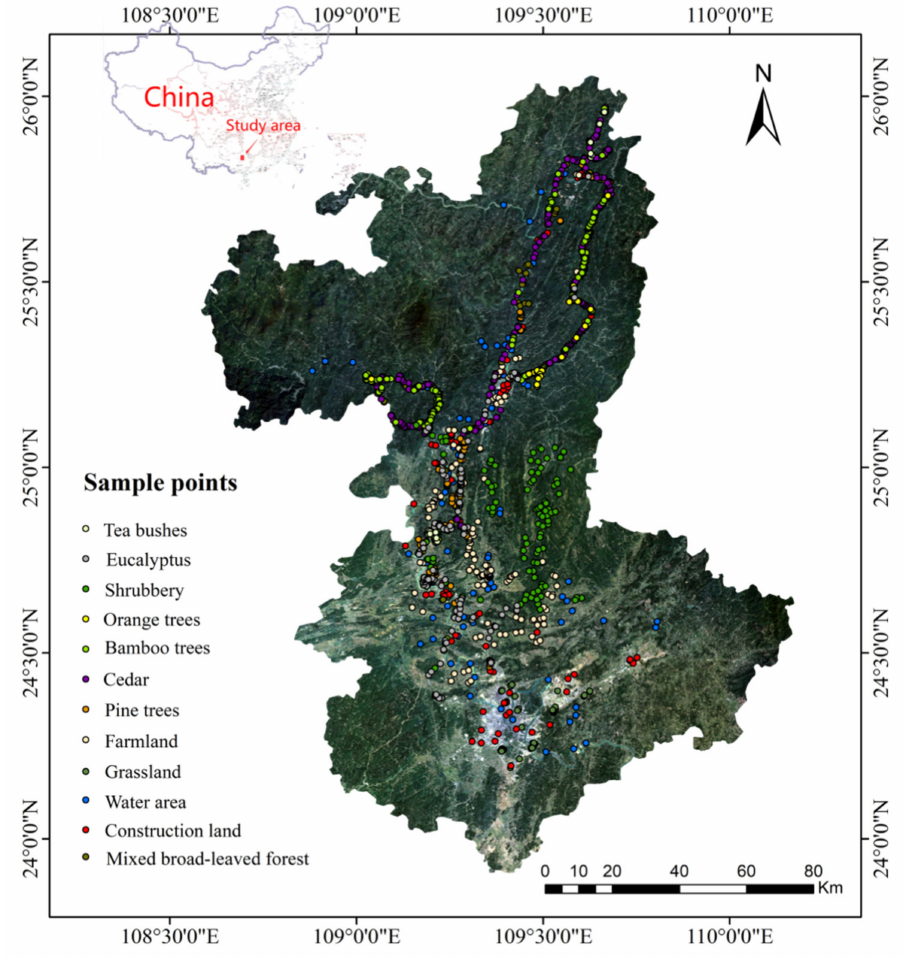
Figure 1. Spatial distribution map of the study area and sampling